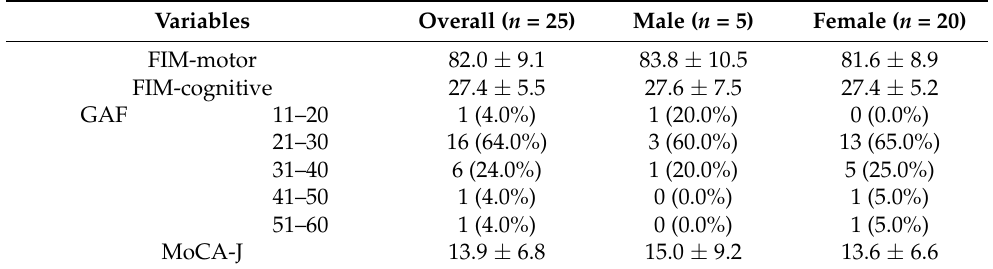
Table 3. Independence level in ADL, mental function, and cognitive function of the participants.